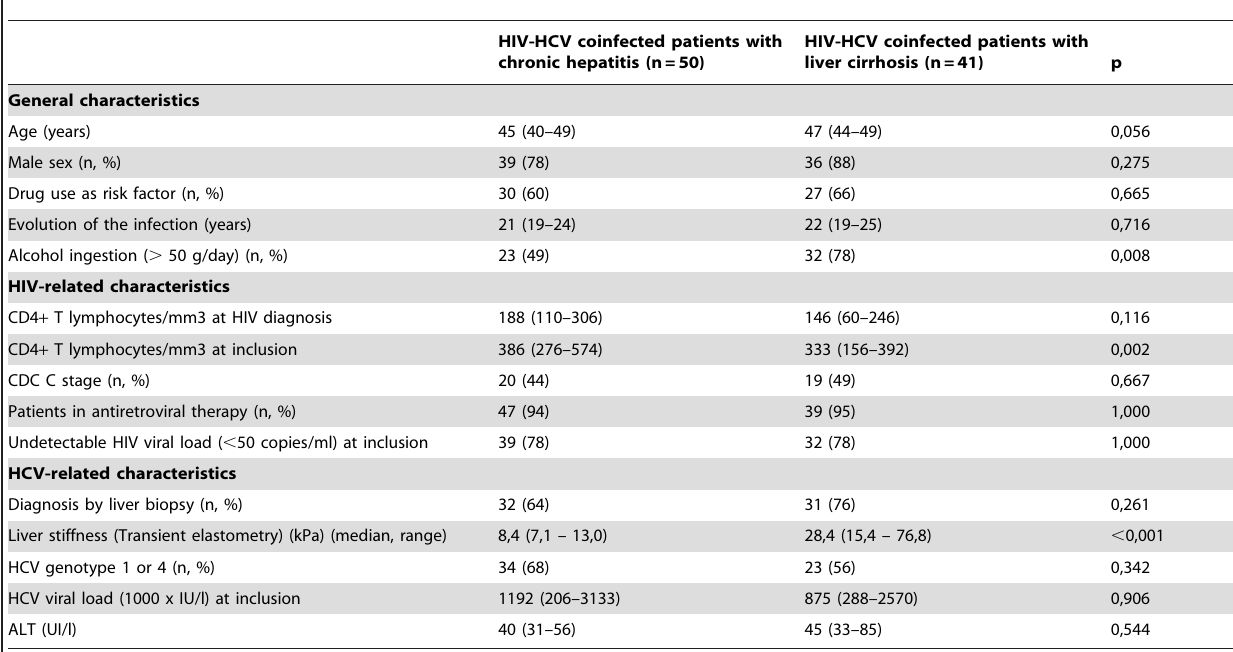
Table 2. Demographic, clinical, virological and immunological characteristics of HIV-HCV coinfected patients with chronic hepatitis or liver cirrhosis.